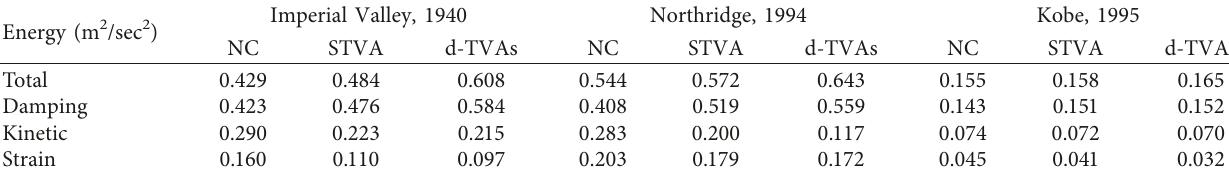
Table 1: Peak energy for the uncontrolled building and controlled with STVA and d-TVAs having mass ratio of 0.05. Energy (m 2 /sec 2